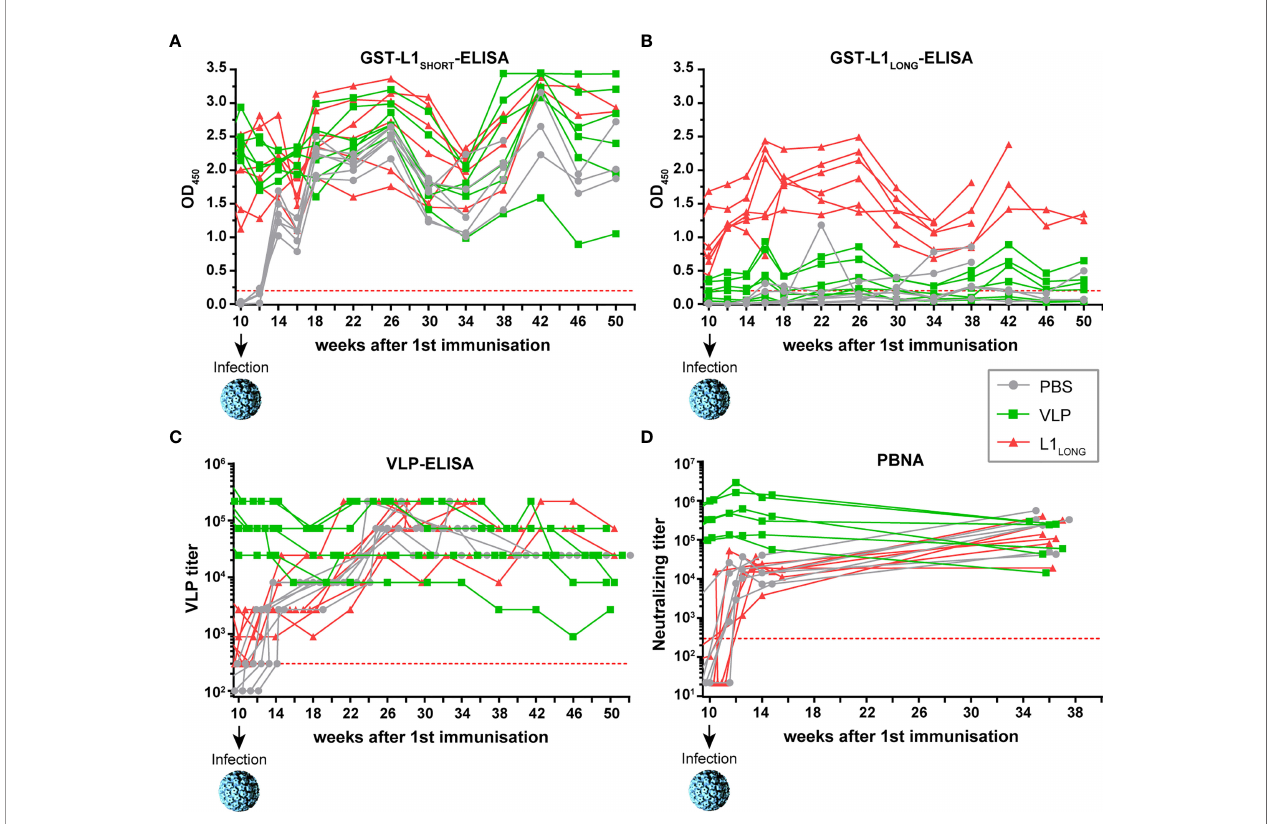
FIGURE 4 | Monitoring seroresponses of vaccinated animals after viral challenge. Follow-up of seroresponses measured by GST-ELISA against (A) L1 SHORT , (B) L1 LONG , (C) VLPs and (D) in PBNA after experimental infection of vaccinated animals at week 10. Prior to infection, these animals were vaccinated with MnPV VLPs (green), MnPV L1 LONG (red) or PBS (grey) (for week 0 to 10, see Figure 2 ). All groups: n = 6 animals. Dashed lines represent the methods ’ cut-off (OD 450 = 0.2 for GST-ELISA or titer of 300 for VLP-ELISA and